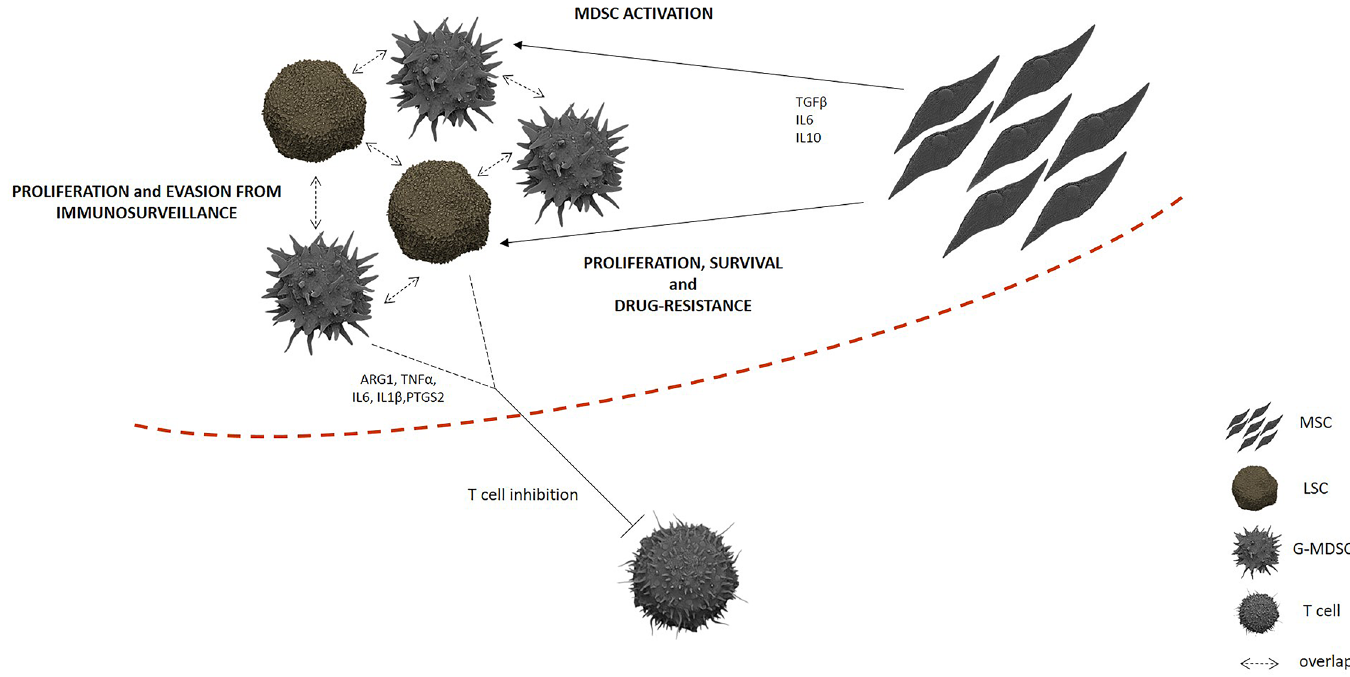
Fig 5. Immunosuppressive niche in CML BM. Even though the expansion of G-MDSC is, at least in part, linked to tumor proliferation in CML patients because of their overlap with leukemic clone, CML-MSC play a centralrole in G-MDSC activation, contributing to create an effective barrier against immune